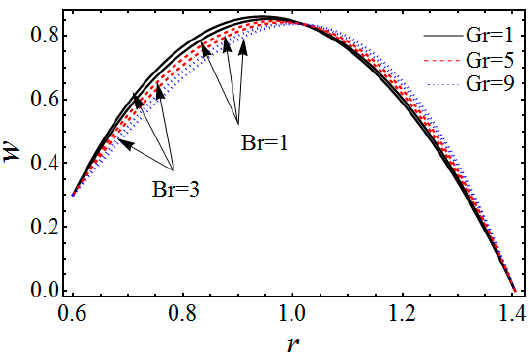
Figure 7. Variation of velocity profile w with ε and V for fixed θ = 0.8, ϕ = 0.1, δ = 0.1, Br = 0.3, Gr = 1, λ 1 = 1, z = 0, t = 0.1, Q = 1.